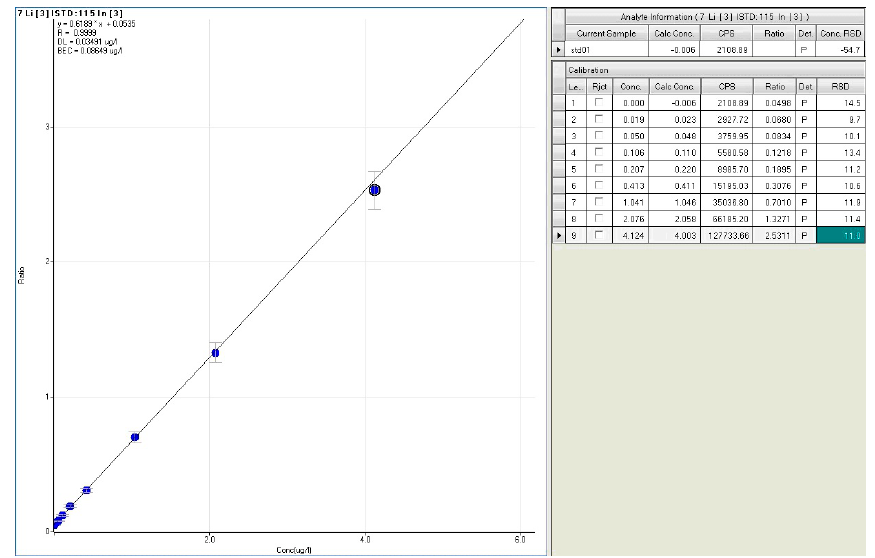
Figure 4. Calibration curve for 7 Li mass. The standard solutions were prepared by dilution from single element stock solution at 1000 mg/L, plus blank solution.